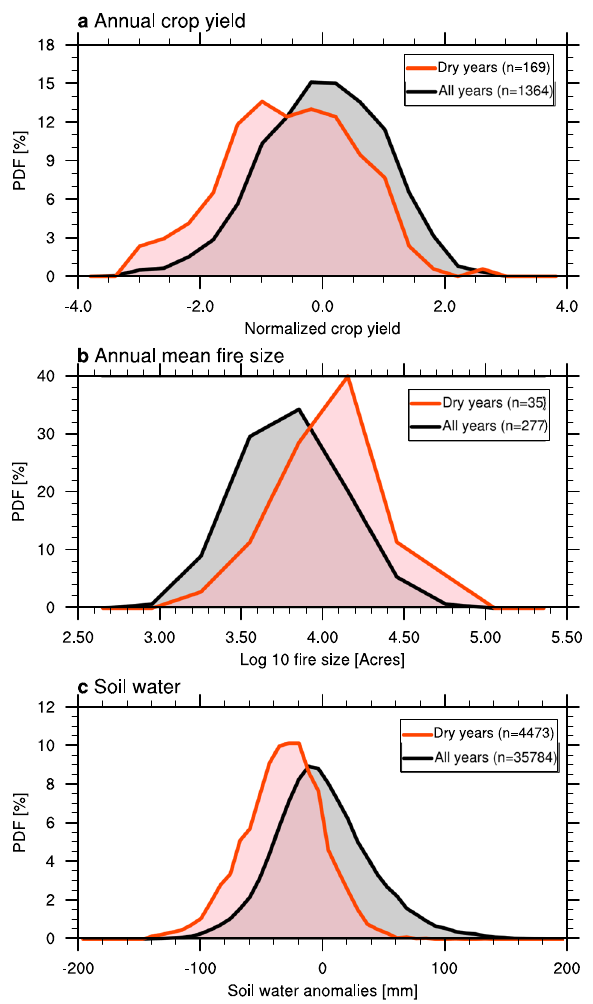
Fig. 7 Impact of Colorado River water shortages on agriculture and wild fi re. Probability distributions of a the normalized and linearly detrended annual crop yields in the Mountain West (barley, corn silage, spring wheat, winter wheat, and alfalfa in Colorado, Nevada, Utah, Wyoming, and Idaho), b mean fi re size in the West (Colorado, Nevada, Utah, Wyoming, Idaho, Oregon, California, Arizona, and New Mexico), and c the linearly detrended soil water anomalies in the Colorado River basin during all years (black) and the years of Colorado River water supply shortages (red). Maximum sample sizes for all years correspond to 1400 (56 years × 5 crops × 5 states) for crop yield, 279 (31 years × 9 states) for fi re size, and (56 years × 639 grid points) for soil water although actual sample sizes for crop yield and fi re size (n) are smaller than these maximum sizes due to missing values. Seven years of Colorado River water supply shortage are shown in yellow shading in Fig. 1. The horizontal axis of mean fi re size b corresponds to the log10